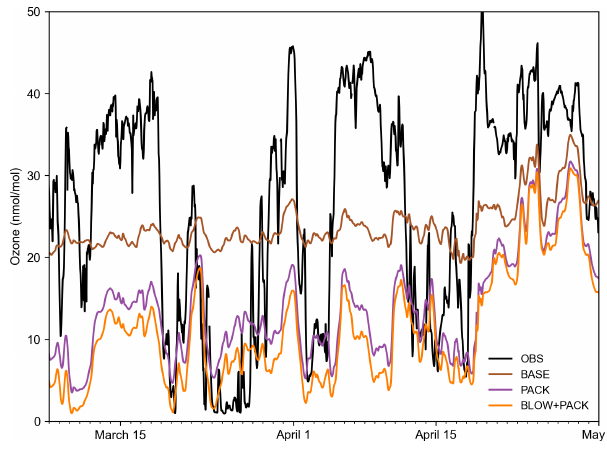
Figure 8. Hourly Utqia˙gvik ozone time series. Hourly time series of BLOW + PACK, PACK, and BASE ozone at Utqia˙gvik in the 2015 Arctic spring. Ozone observations at BARC in black (McClure- Begley et al., 2014), BASE ozone in brown, PACK ozone in purple, and BLOW + PACK ozone in orange. Gaps indicate missing obser- vational data.